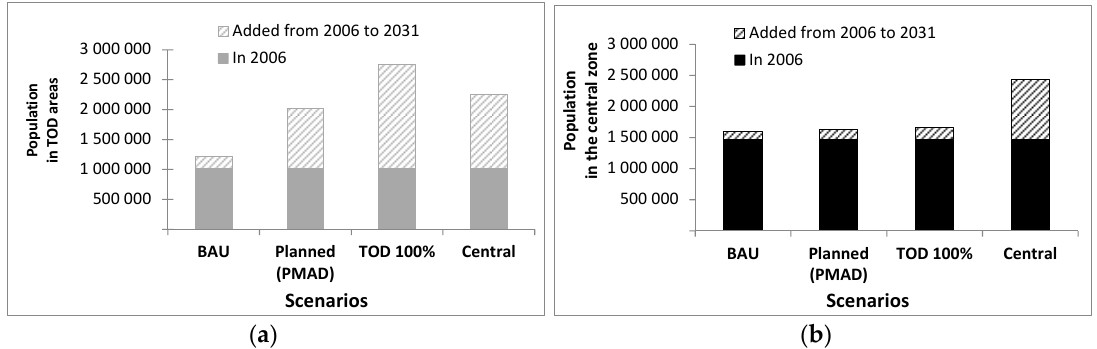
Figure 3. Population distribution, according to 2031 scenarios; ( a ) Population living in TOD areas; ( b ) Population living in the central